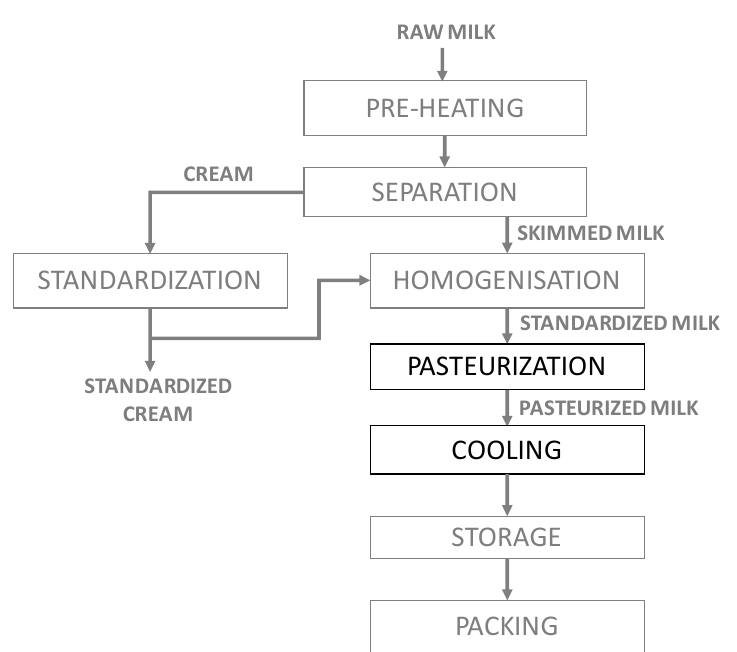
Figure 2. Scheme of a “typical” process for pasteurized milk production (from authors’ elaboration).